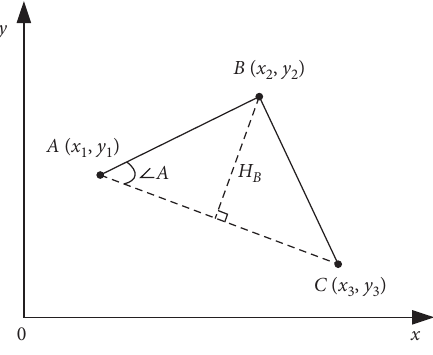
Figure 4: Simplification of contour offset